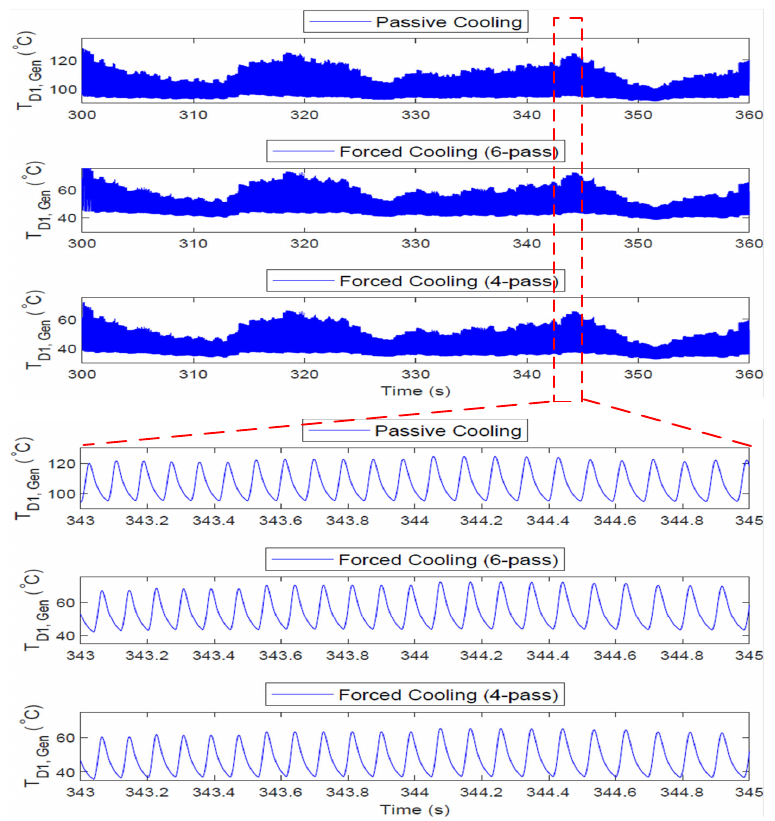
Figure 22. Comparison of cooling systems in terms of diode junction temperature cycling considering both turbulence and waves in tidal stream velocity shown in Figure 16.